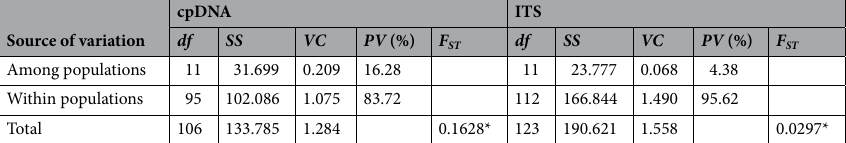
Table 4. Analyses of molecular variance (AMOVA) of cpDNA haplotypes and ITS genotypes for populations of P. armeniaca . df , degrees of freedom; SS , sum of squares; VC , variance components; PV , percentage of variation; F ST , genetic diffrentiation; * P <